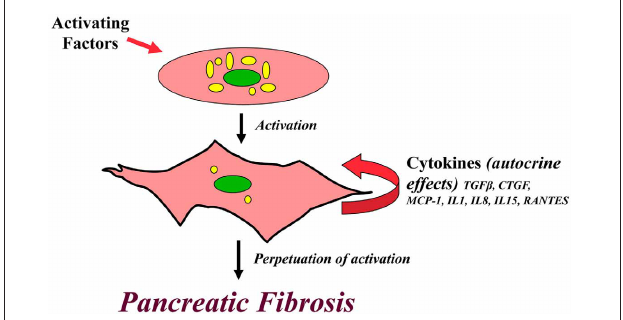
FIGURE 3 | Perpetuation of PSC activation. A diagrammatic representation of the postulated pathway for a perpetually activated state for PSCs. Pancreatic stellate cells are activated via paracrine pathways by exogenousfactors such as cytokines, oxidant stress, ethanol and its metabolites. Activated PSCs synthesize and secrete endogenouscytokines which influence PSC function via autocrine pathways. It is possible that this autocrine loop in activated PSCs perpetuates the activated state of the cell, even in the absence if the initial trigger factors, leading to excessive ECM production and eventually causing pancreatic